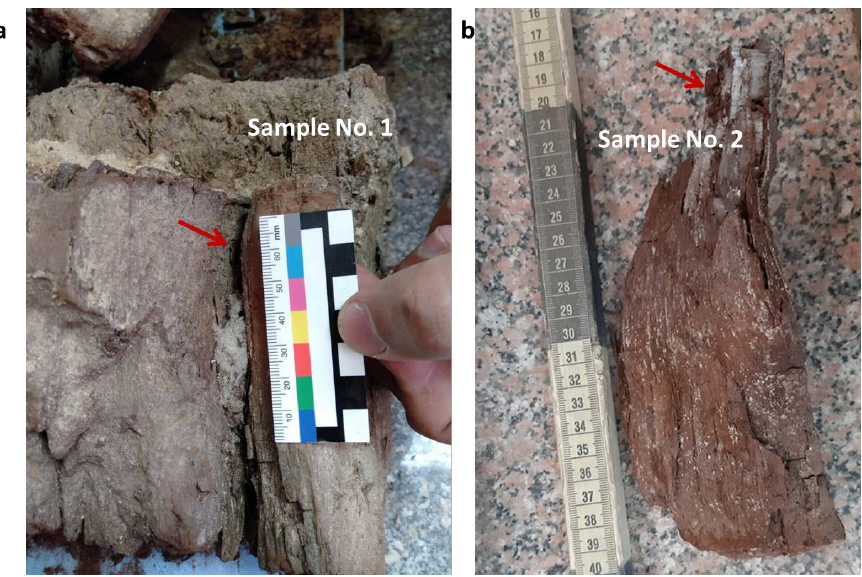
Figure 2. Sampling points (red arrows) of the archaeological wood samples #1 ( a ) and #2 ( b ).